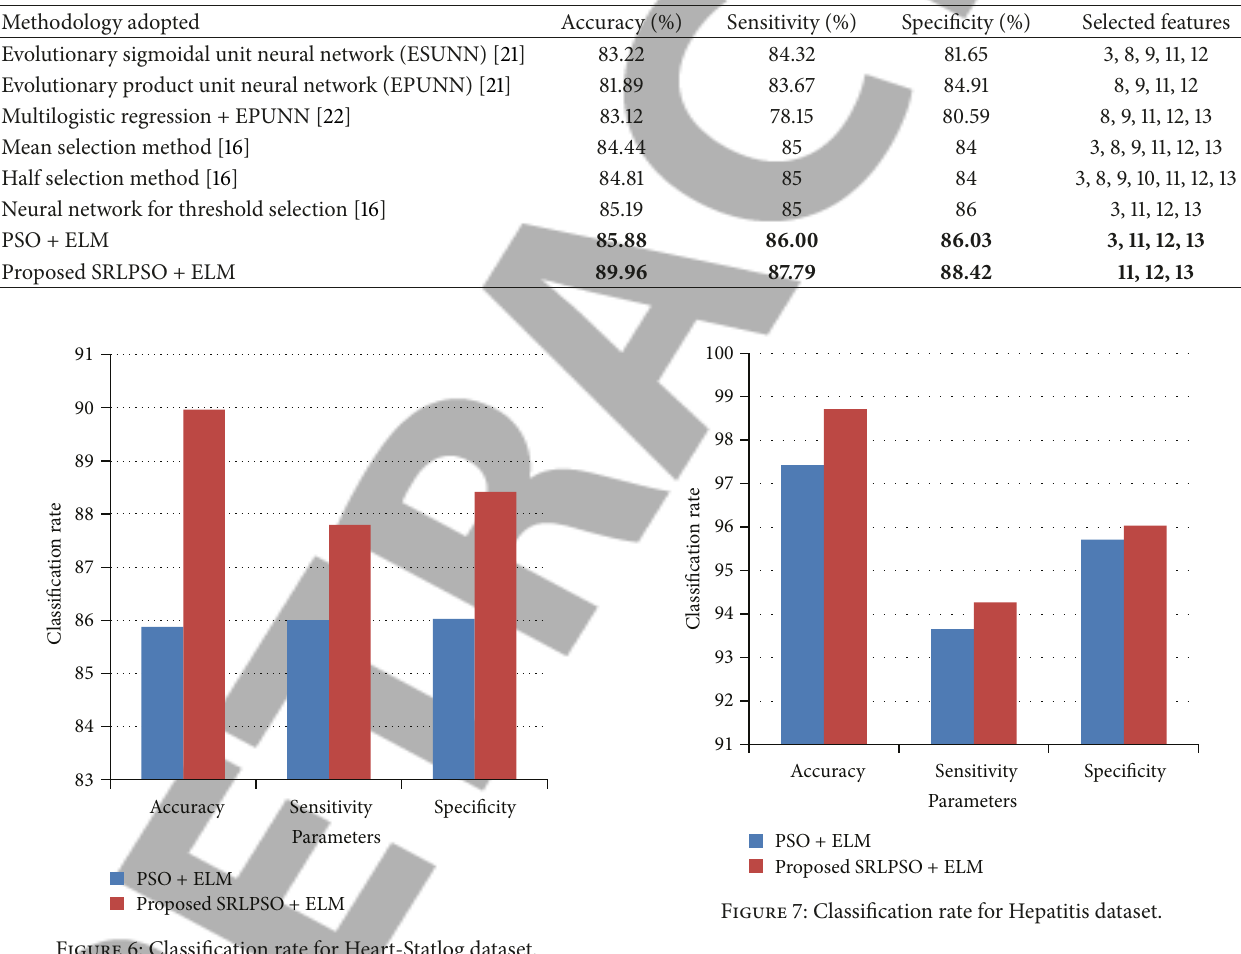
Table 5: Classification results with Heart-Statlog dataset.